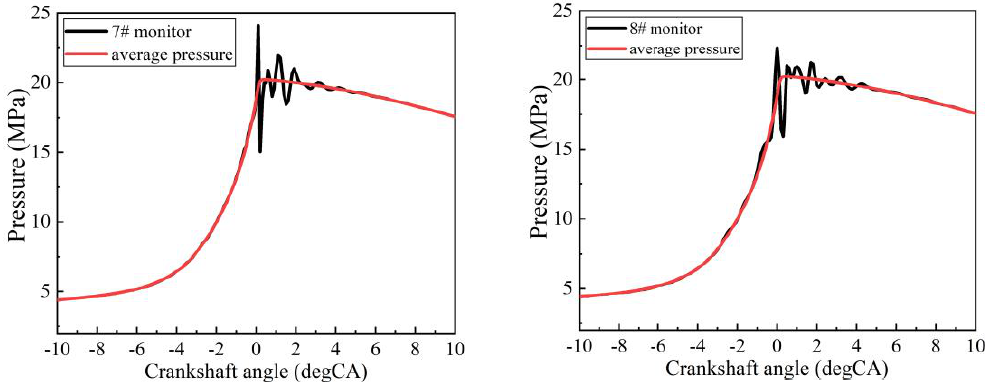
Figure 7. Pressure curves for 8 monitor points (CR = 10.3, ignition time = − 14 degCA).